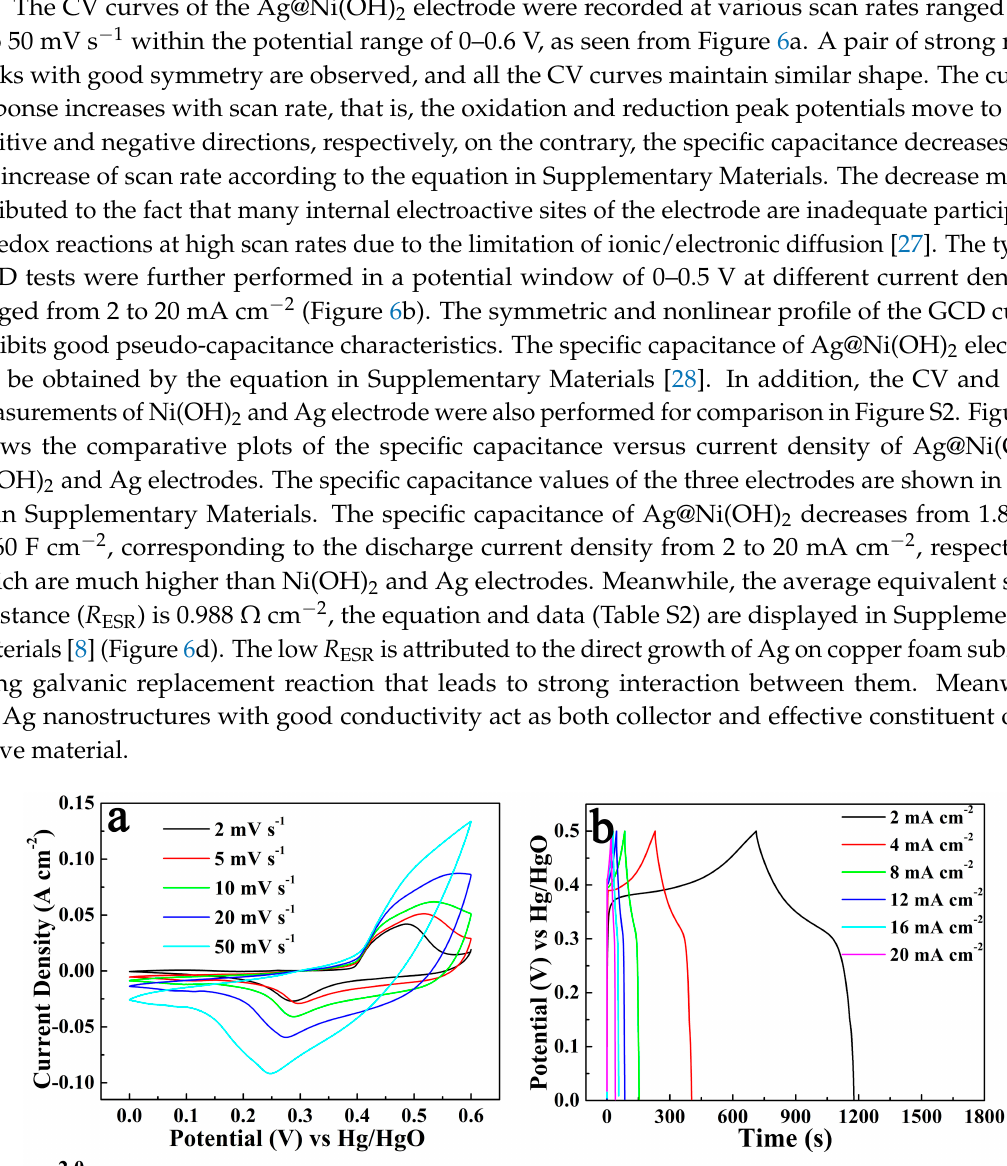
Figure 7. Cycling performances of the Ag@Ni(OH) 2 electrode. The resulting hierarchical Ag@Ni(OH) 2 samples available in high performance binder-free electrodes may be mainly attributed to the following factors: (1) the Ag nanoflowers directly grown on copper substrate by the electroless deposition techniques reduces the contact resistance, and provides a natural pathway for electron transport thereby [22]; (2) The use of Ag nanoflowers as backbone provides adequate surface area for subsequent Ni(OH) 2 layer deposition and allows fast electric and ionic conduction through the electrode owing to its good electrical conductivity [27]; (3) The electrodeposition of Ni(OH) 2 nanospheres are composed by smaller nanoparticles, which interconnect with each other on the surface of the Ag nanoflowers and this generates abundant